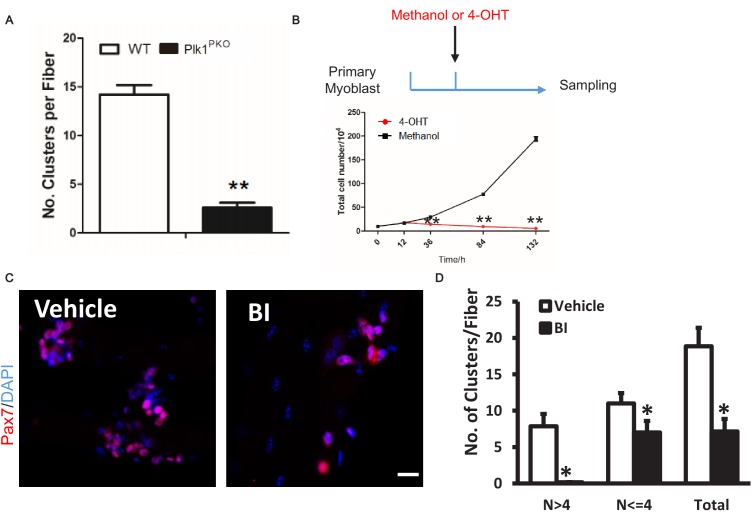
Plk1 deletion in MuSCs leads to cell cycle arrest.(A) Quantification of MuSCs on 3 day cultured EDL myofibers isolated from WT and Plk1PKO mice 14 days after TMX induction, data represent mean ± s.e.m. (t-test: **p<0.01; n = 4, biological replicates, MuSCs from at least 10 fibers were counted for each mouse); (B) Total myoblast numbers after 0, 12, 36, 84 and 132 hr methanol or 4-OHT induction, data represent mean ± s.e.m. (t-test: **p<0.01; n = 4 biological replicates, cell numbers were counted from three replicates from four WT or Plk1PKO myoblasts); (C) Immunofluorescence of Pax7 and DAPI in MuSCs on 3 day cultured EDL myofibers isolated from BI or vehicle treated mice, scale bar: 10 μm; (D) Quantification of (C), data represent mean ± s.e.m. (t-test: *p<0.05; n = 4, biological replicates, MuSCs from at least 10 fibers were counted for each mouse).